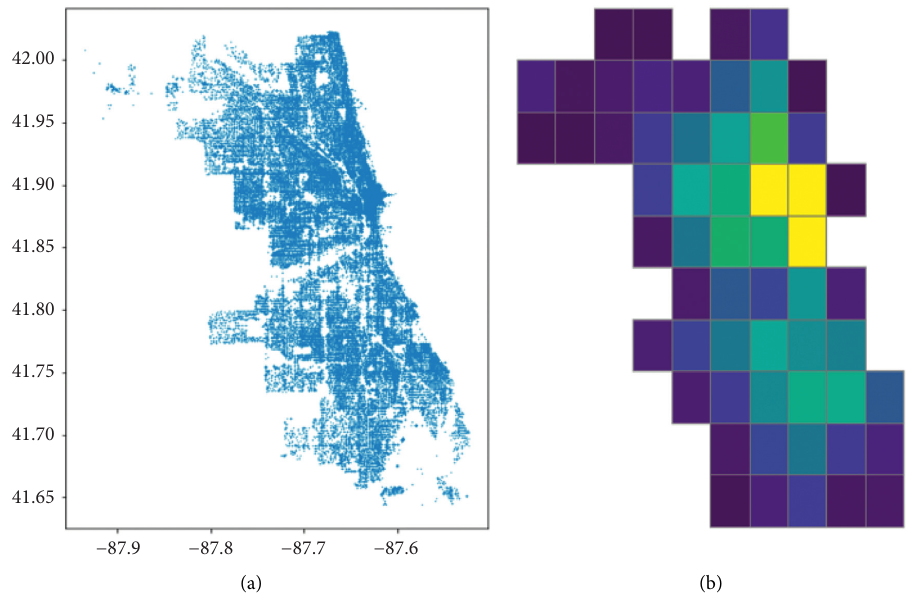
Figure 1: Chicago 2018 crime distribution. (a) The map of Chicago city in 2018, and each blue point means a crime. (b) The location of all grids that have crime.